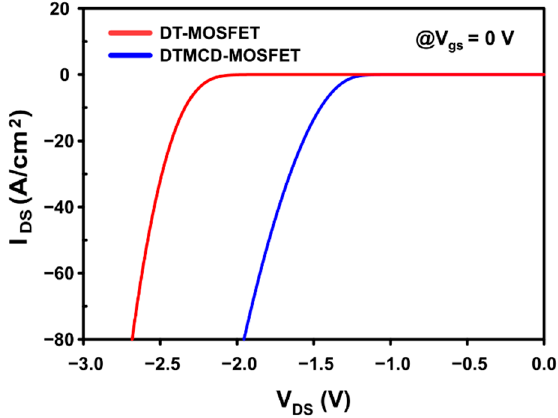
Figure 9. Third quadrant characteristics of DT-MOSFET and DTMCD-MOSFET.